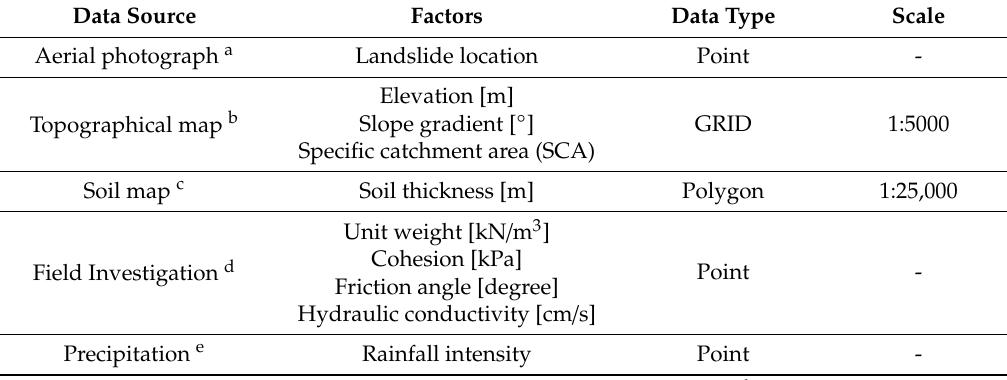
Table 1. Landslide-related factors used to construct spatial database.